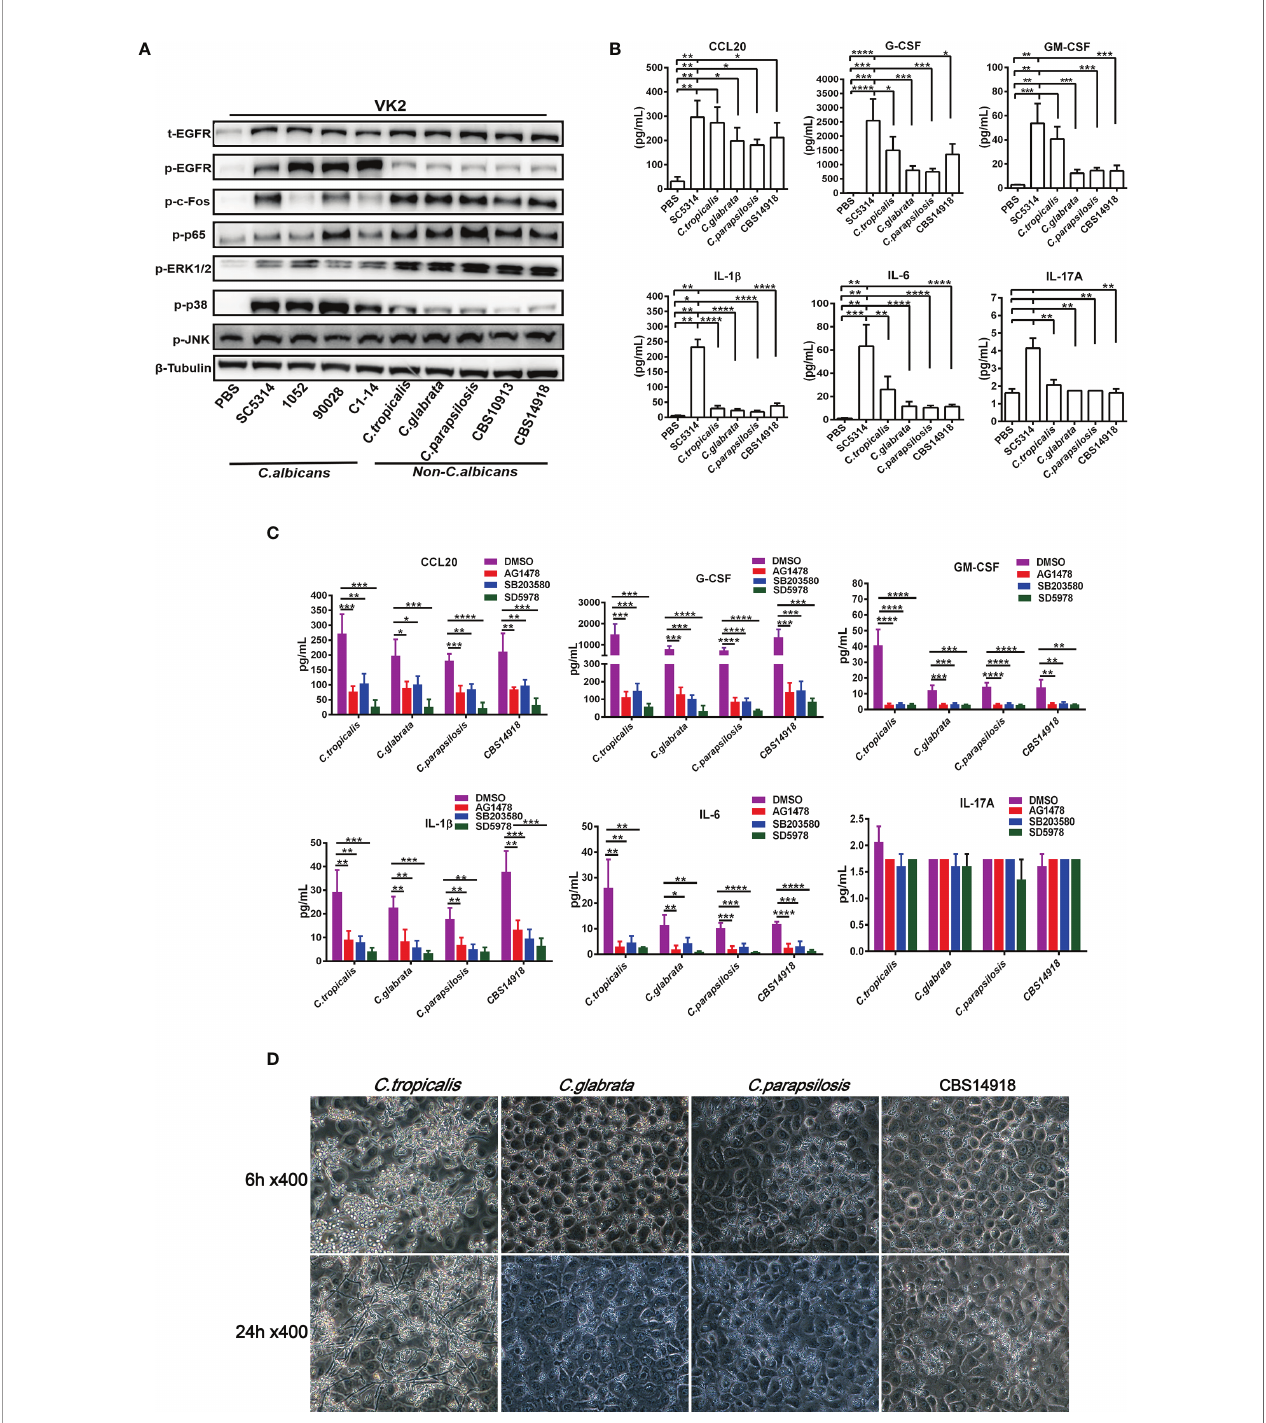
FIGURE 4 | Divergent activation of EGFR and MAPK and cytokine induction by C. albicans and non-albicans Candida species. VK2/E6E7 cells were stimulated with C. albicans (SC5314, 1052, ATCC90028 and C1-14) and non-albicans Candida (NAC) isolates C. tropicalis , C. glabrata , C. parapsilosis , CBS10913 and CBS14918) (MOI=5) respectively. Protein lysates were taken at 6 h post-infection for western blotting analysis (A) . Cytokines induced by C. albicans and NAC isolates (MOI=0.01) were assessed at 24h post-infection via Luminex (B) . All inhibitors suppressed NAC isolates-induced cytokines production (C) . Morphology of C. tropicalis , C. glabrata , C. parapsilosis and CBS14918 strains on VK2/E6E7 cells at 6 and 24 h post infection (D) . Data are representative of three independent experiments. Error bars represent SD, *p < 0.05, **p < 0.01, ***p < 0.001, ****p <